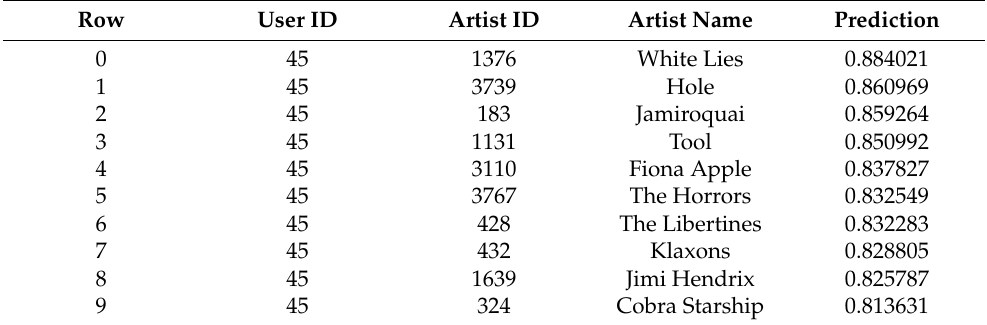
Table 2. List of Top 10